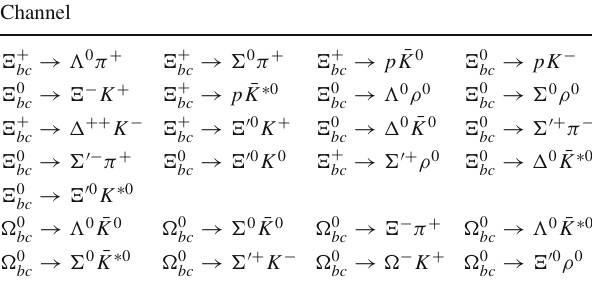
Table 6 Allowed decay channels of (cid:2) bc and (cid:3) bc